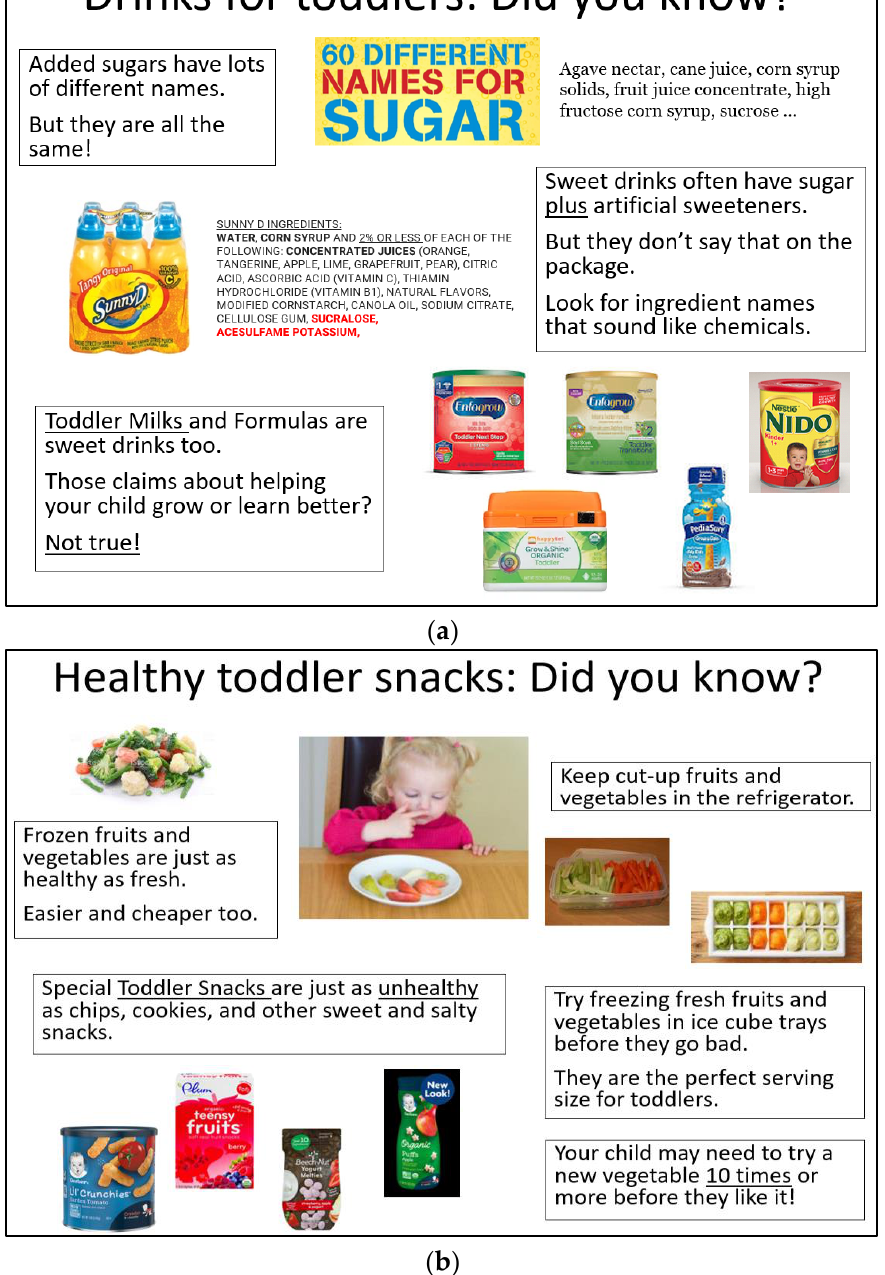
Figure A2. Stimuli presented in the focus groups: Additional information and tips for ( a ) drinks for toddlers; ( b ) snacks for toddlers.